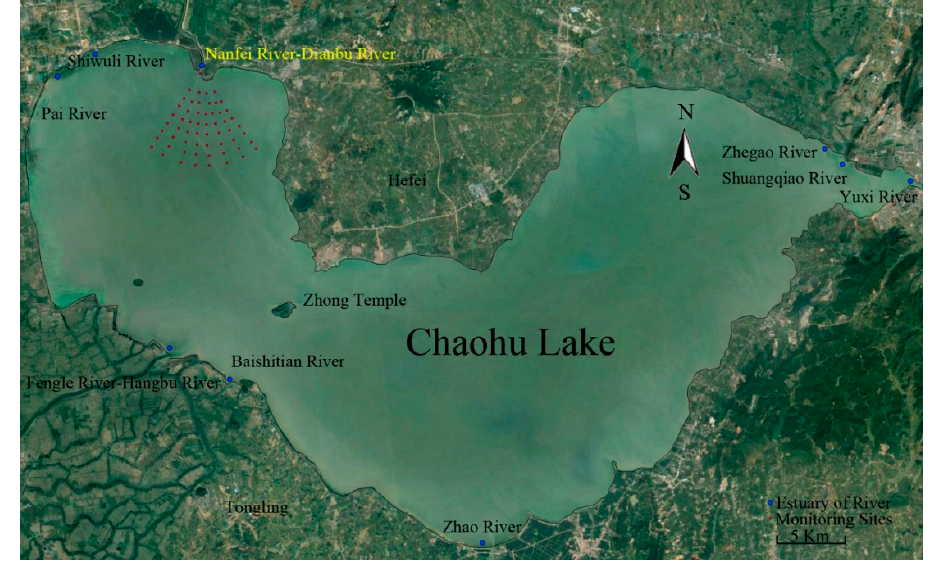
Figure 1. The region and monitoring sites of Chaohu Lake.